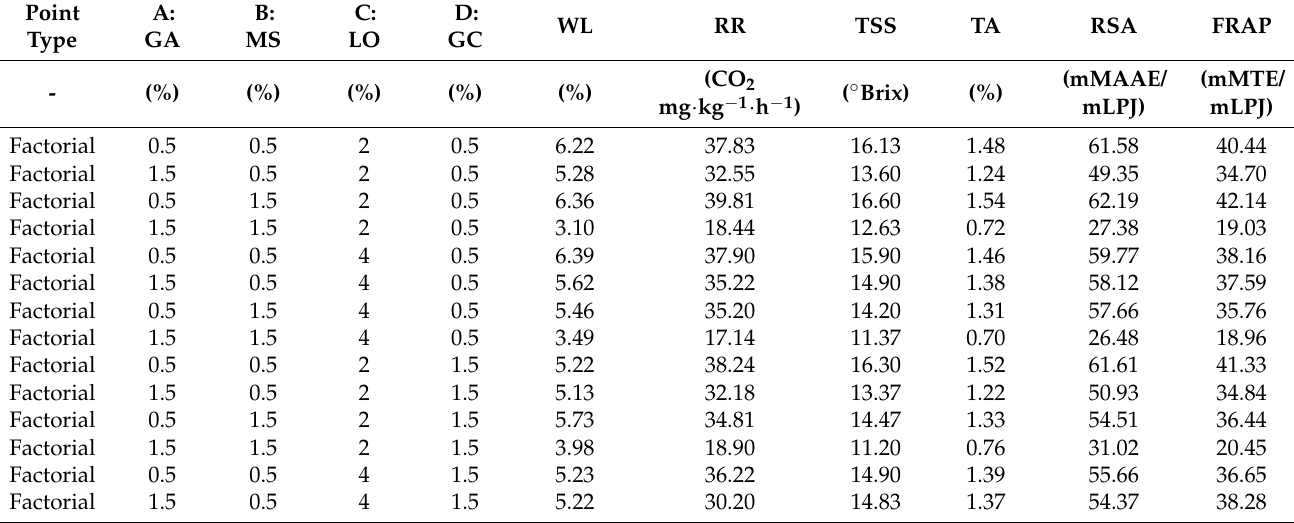
Table 4. The central composite design and experimental data obtained for starch and gum arabic based edible coatings applied on “Wonderful” pomegranate fruit during cold storage (GA—gum arabic, MS—maize starch, LO—lemongrass oil,